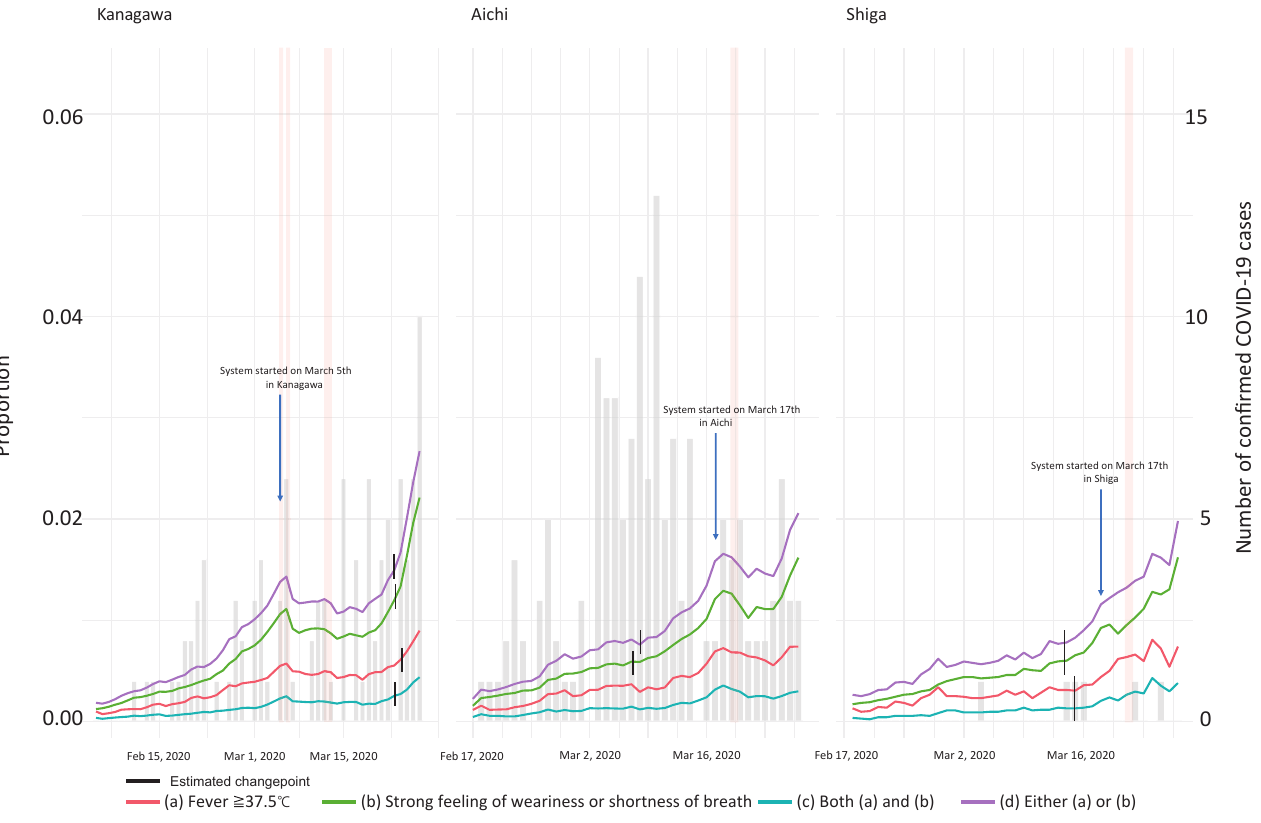
Figure 2. Monthly trend in each prefecture (left: Kanagawa, middle: Aichi, right: Shiga). Red line, green line, blue line, and purple line indicate the proportion of participants who have a fever (a), a strong feeling of weariness or shortness of breath (b), both (a) and (b), and either (a) or (b), respectively. Gray bar indicates the reported number of COVID-19-positive cases in each prefecture. Pink bands are the banner